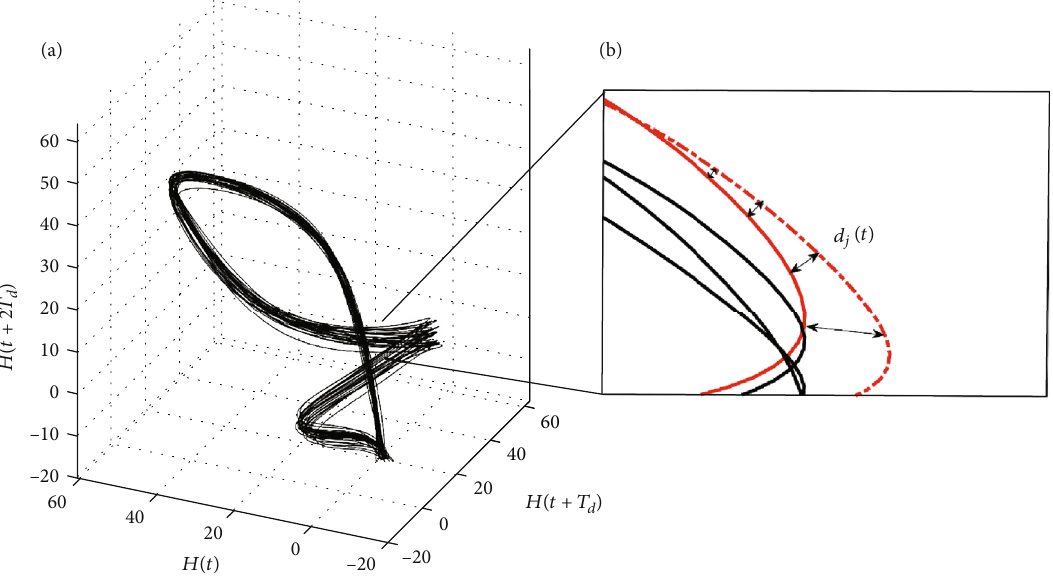
Figure 1: Schematic of divergence of the nearest neighboring trajectories in the reconstructed attractor. (a) Attractor reconstructed by delaying time series data by a time delay ( T d ) and three embedded dimensions. (b) Euclidean distance ( d j ð t Þ ) in the reconstructed